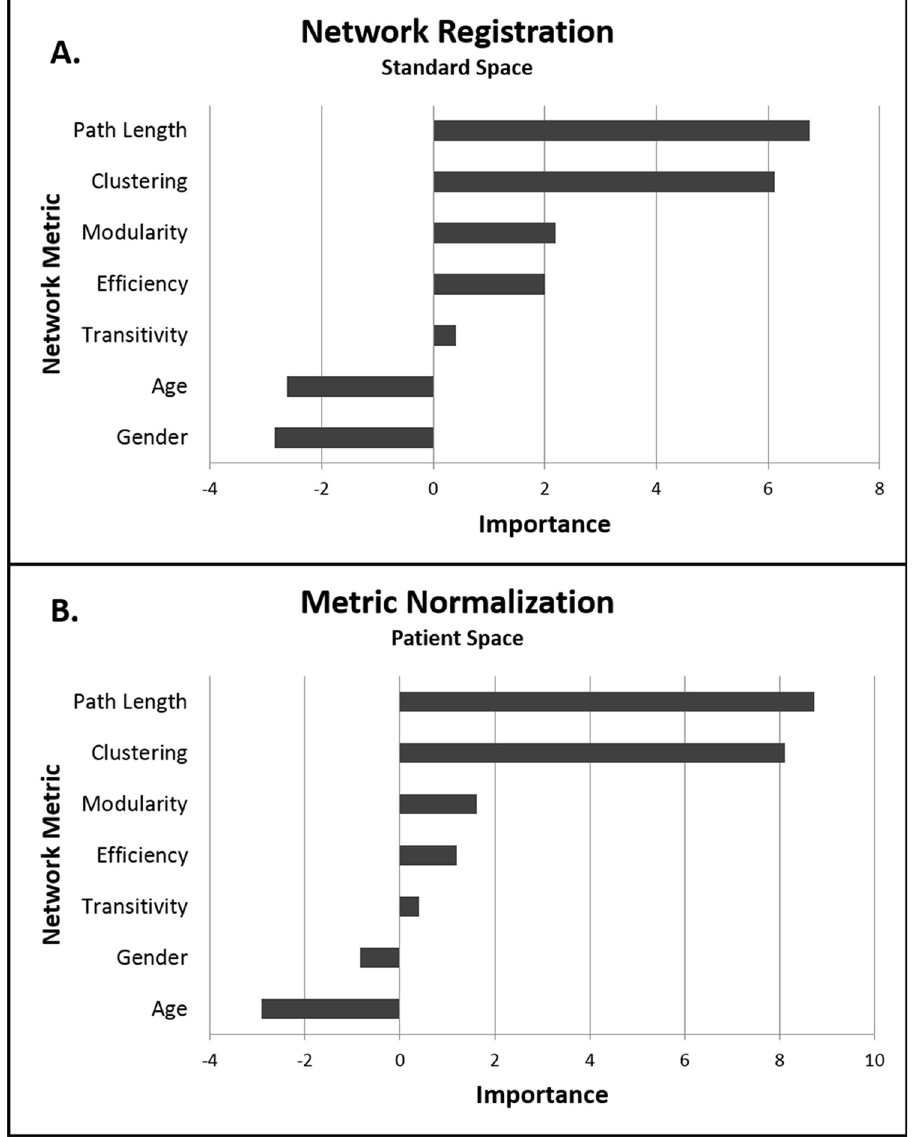
Fig 1. Importance of global metrics of network architecture to intelligence quotient (IQ) prediction. Metrics were computed in (a) standard space or (b) in patient space with normalization of output metrics to a random network of the same size. The independent contribution of each metric was estimated as the error of the learning algorithm’s IQ prediction compared to the error which results when that metric is negated. The most negative value of importance defines the limit of noise. Hence, variables with importance greater in magnitude than the most negative variable are